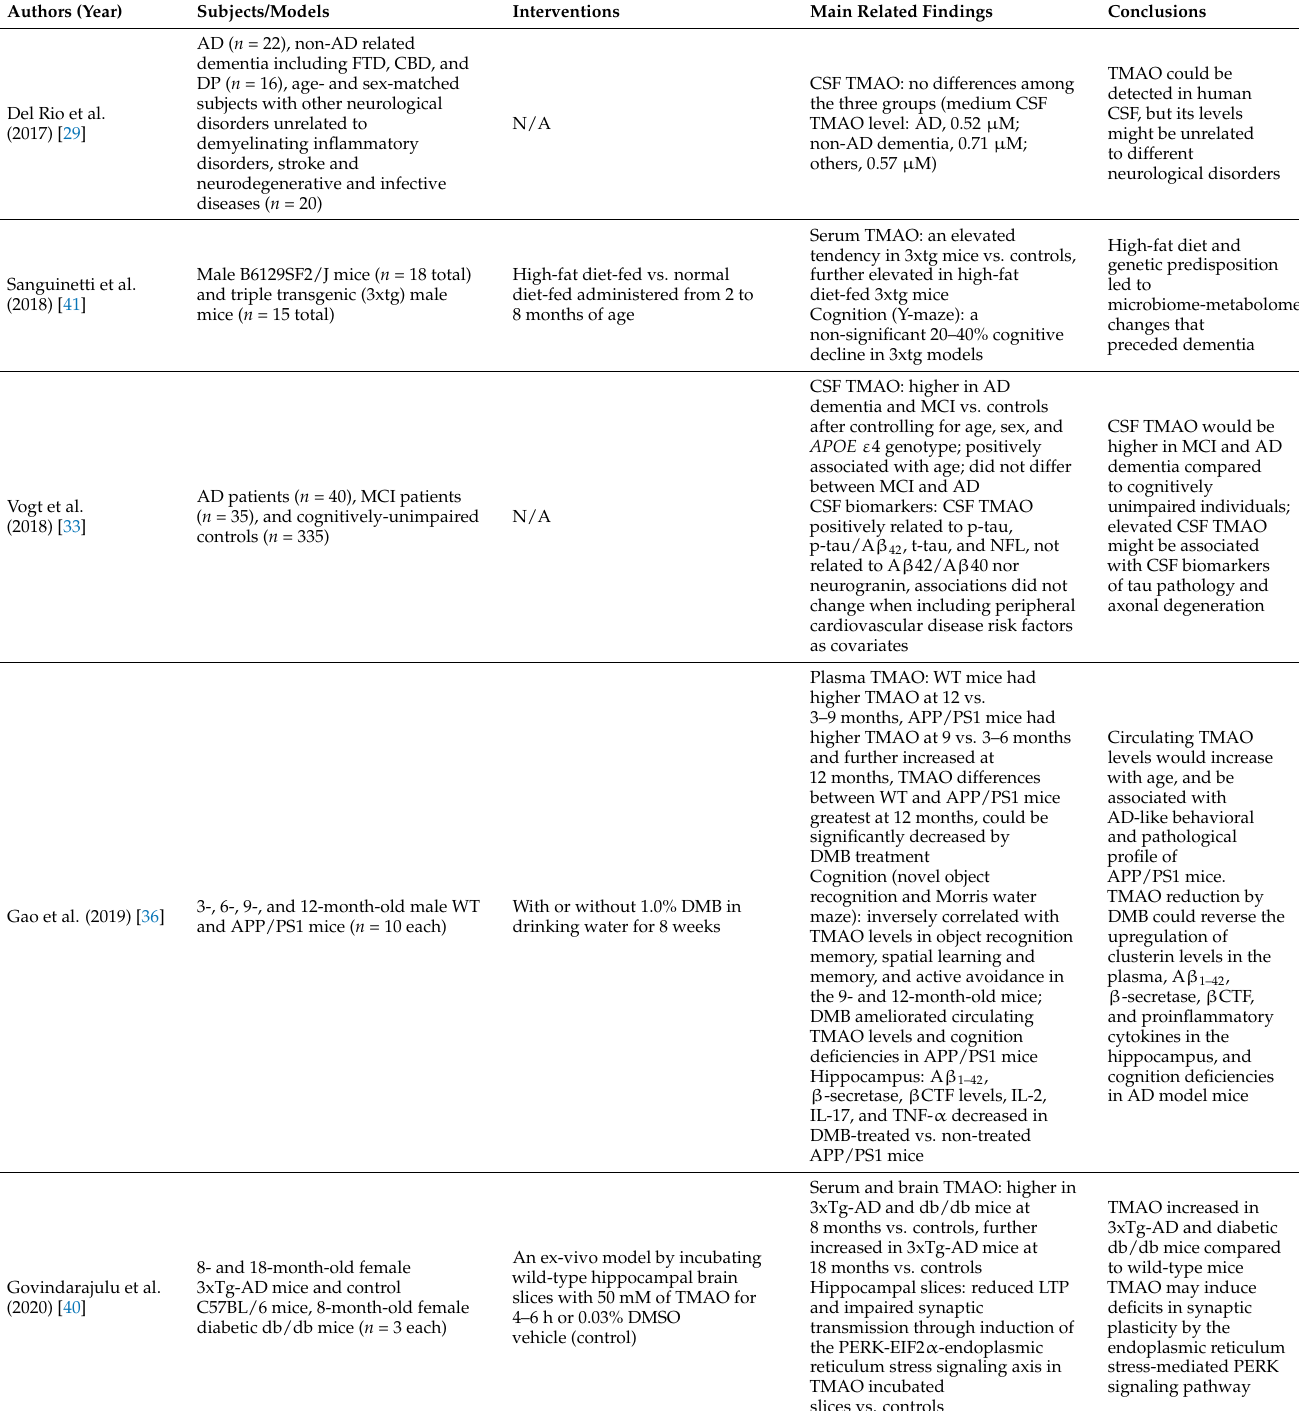
Table 2. Main findings of TMAO in relation to